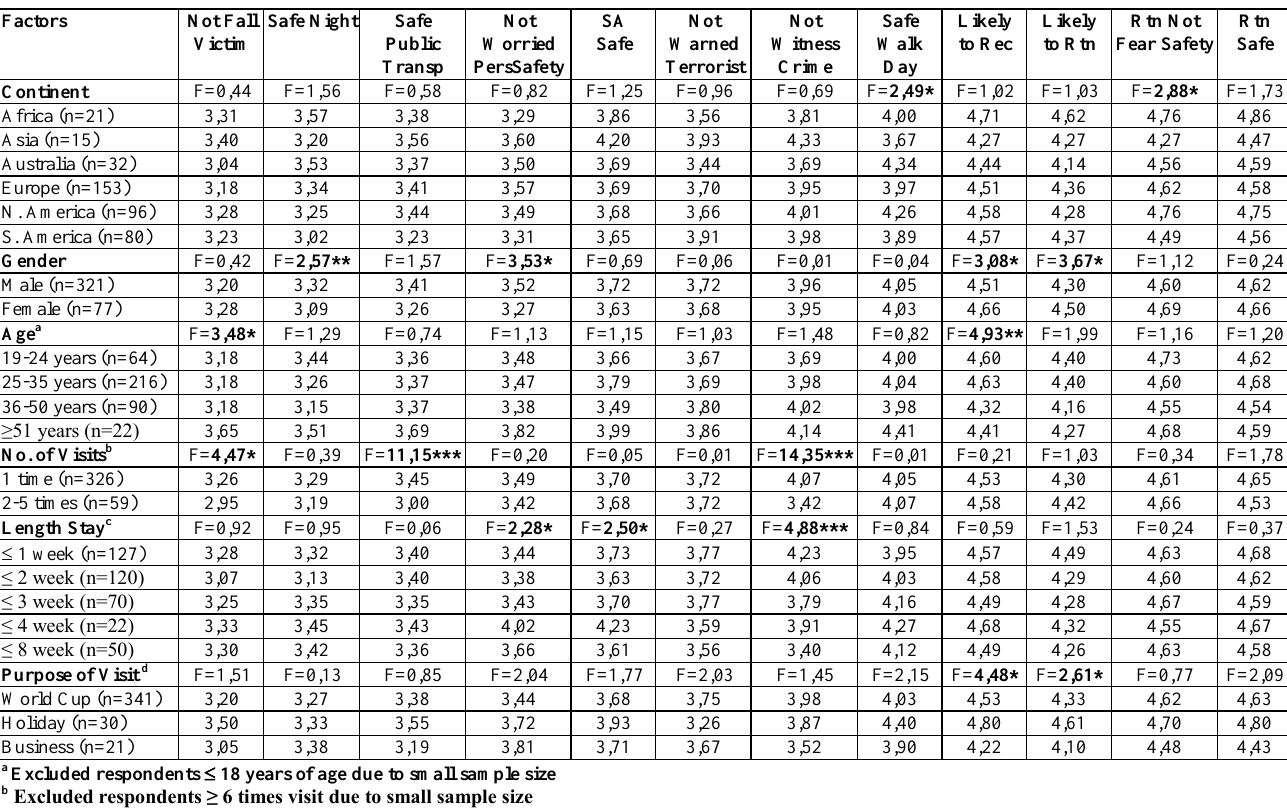
Table 2: Summary of ANOVA (F-values and mean scores)